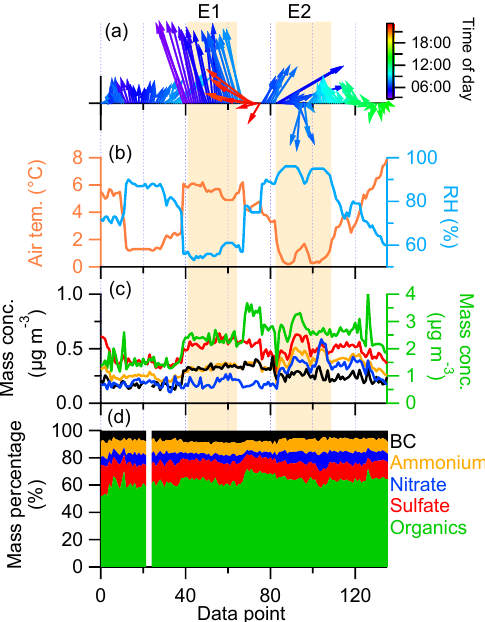
Figure 7. The high aerosol loading periods based on nitrate (>average + 2 σ) accompanying meteorological data.